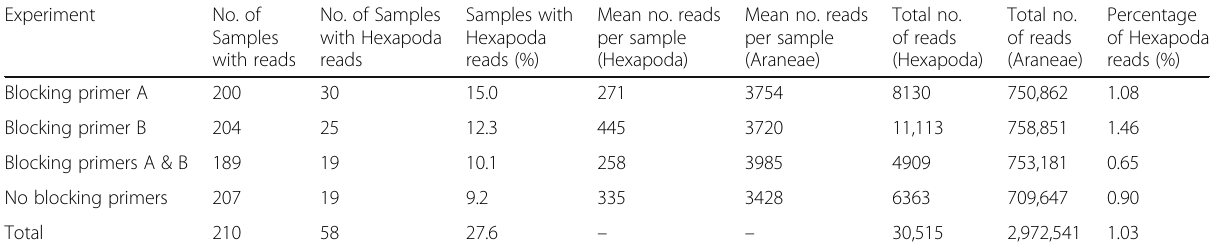
Table 2 Summary of Illumina sequencing. Results based on the four PCR (blocking primer) settings are separately shown Experiment